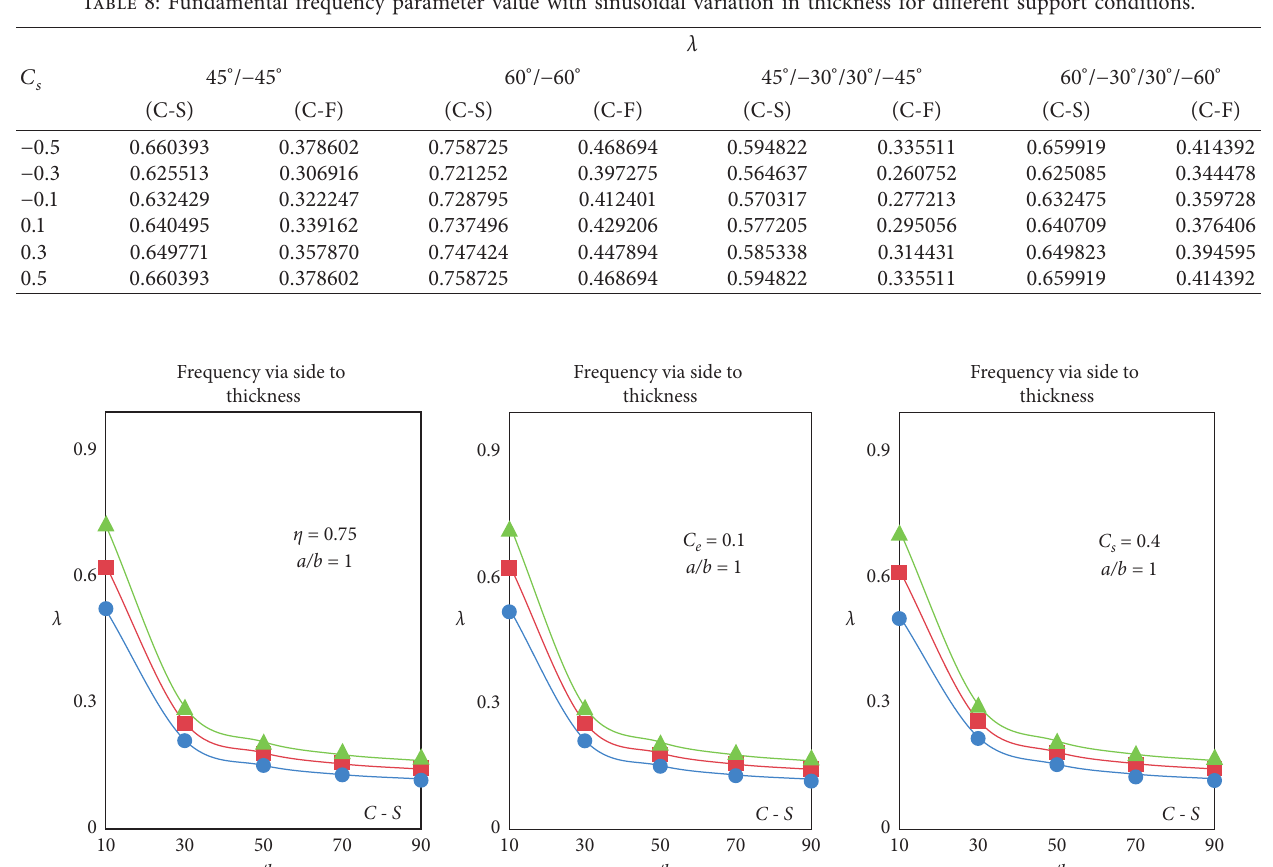
Table 8: Fundamental frequency parameter value with sinusoidal variation in thickness for different support